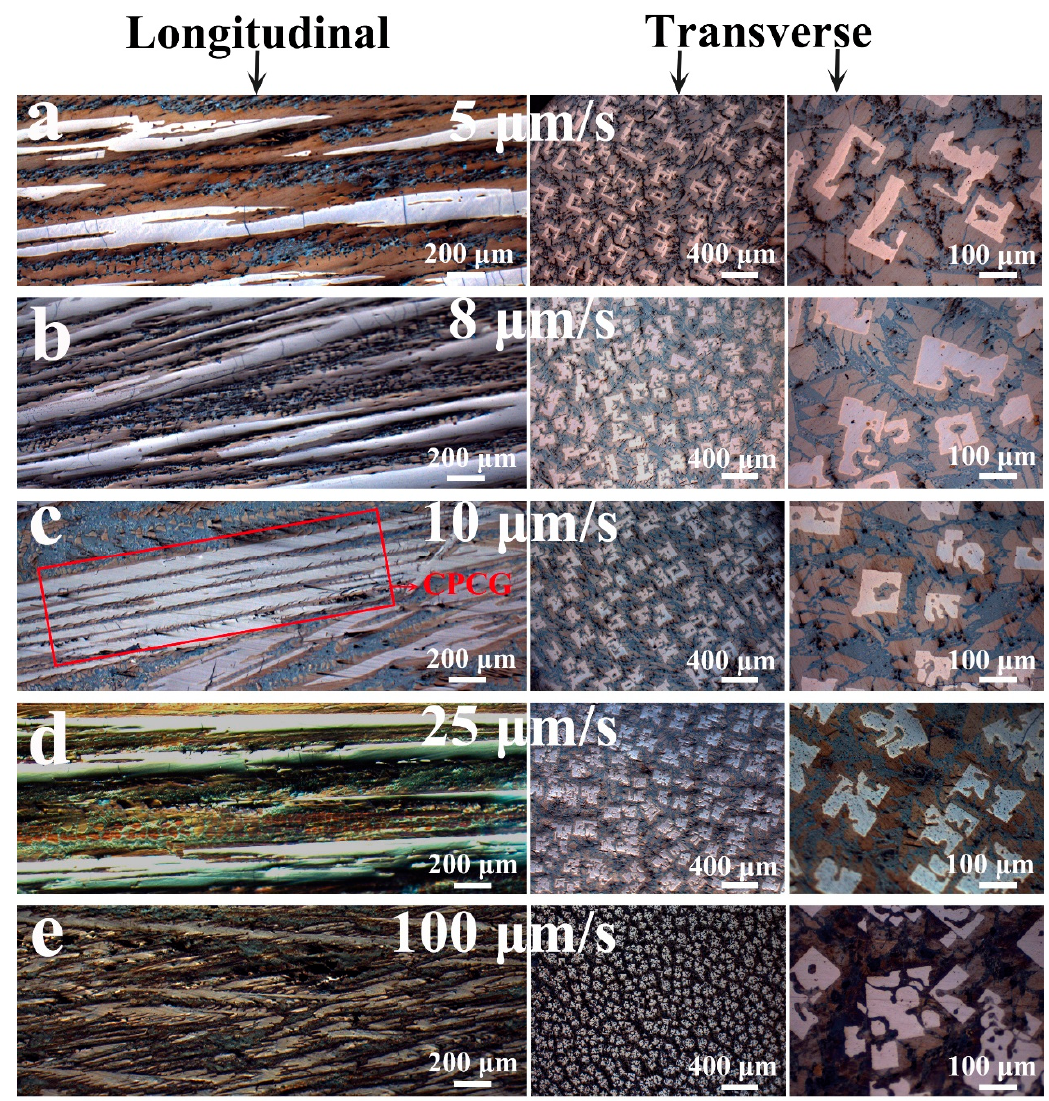
Figure 1. Optical microscopy (OM) images of CuCe alloys at varying withdrawal rates. ( a ) 5 μ m/s, ( b ) 8 μ m/s, ( c ) 10 μ m/s, ( d ) 25 μ m/s, and ( e ) 100 μ m/s.